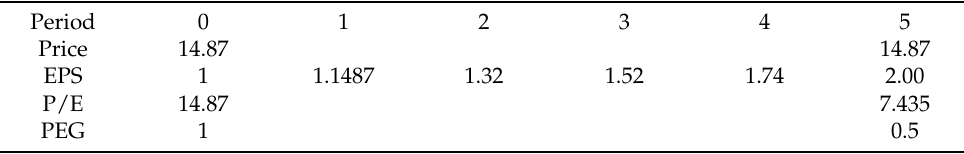
Table 2. Price Growth at 0% and Earnings Growth at 14.87% Over 5